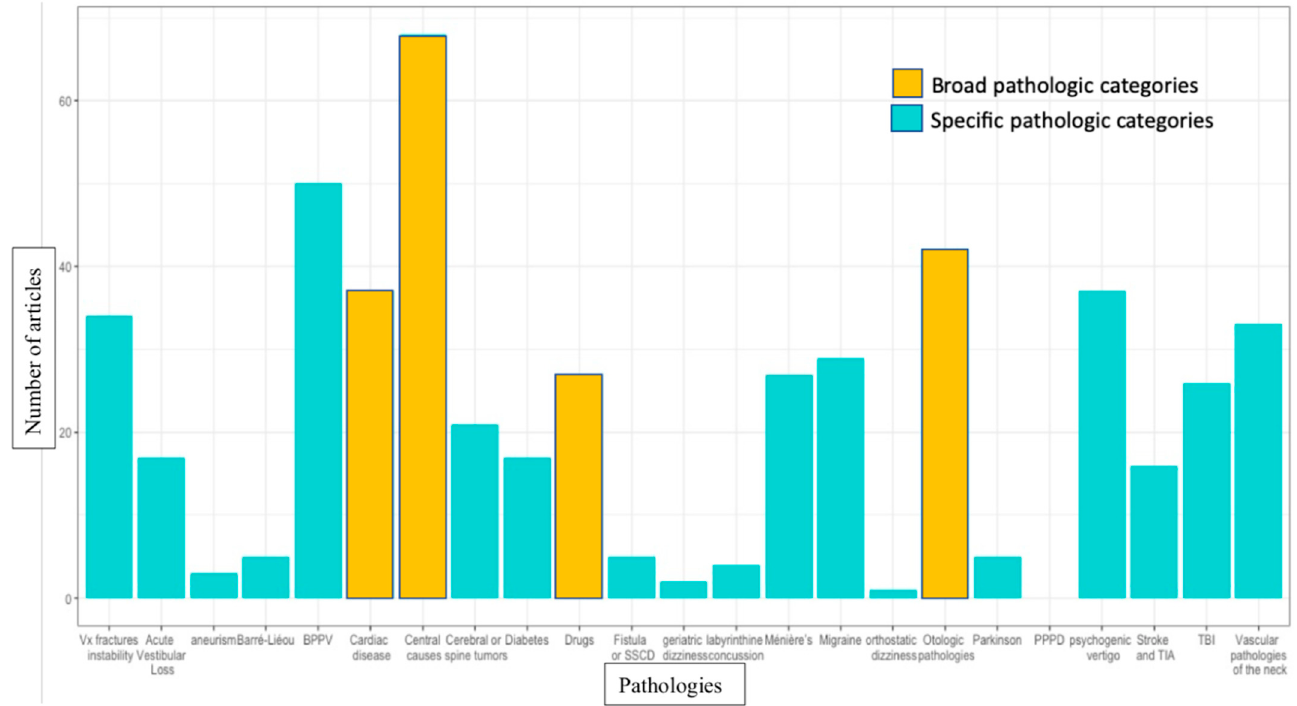
Figure 4. Pertinent differential diagnosis. SSCD: superior semicircular canal dehiscence syndrome; BPPV: benign paroxysmal positional vertigo; PPPD: persistent postural-perceptual dizziness; TIA: transient ischemic attack TBI: traumatic brain injury Vx: vertebral. Table 2. Occurrences of differential diagnoses in articles mentioning different subpopulations of PCGD.